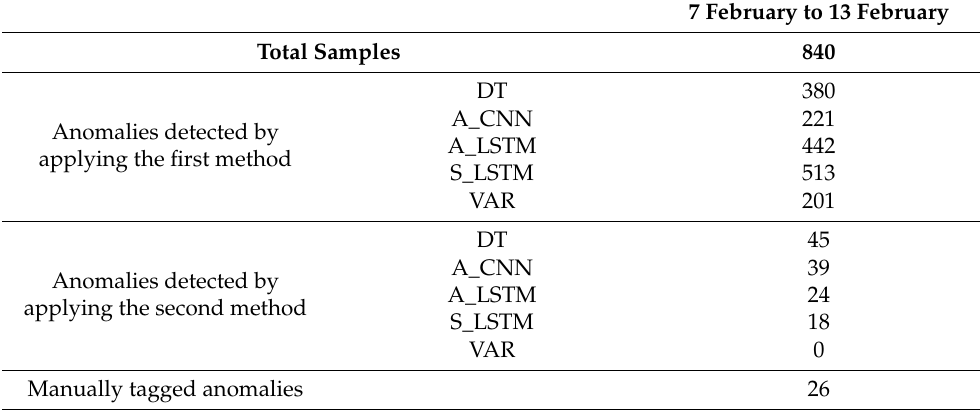
Table 5. Number of automatically detected anomalies.